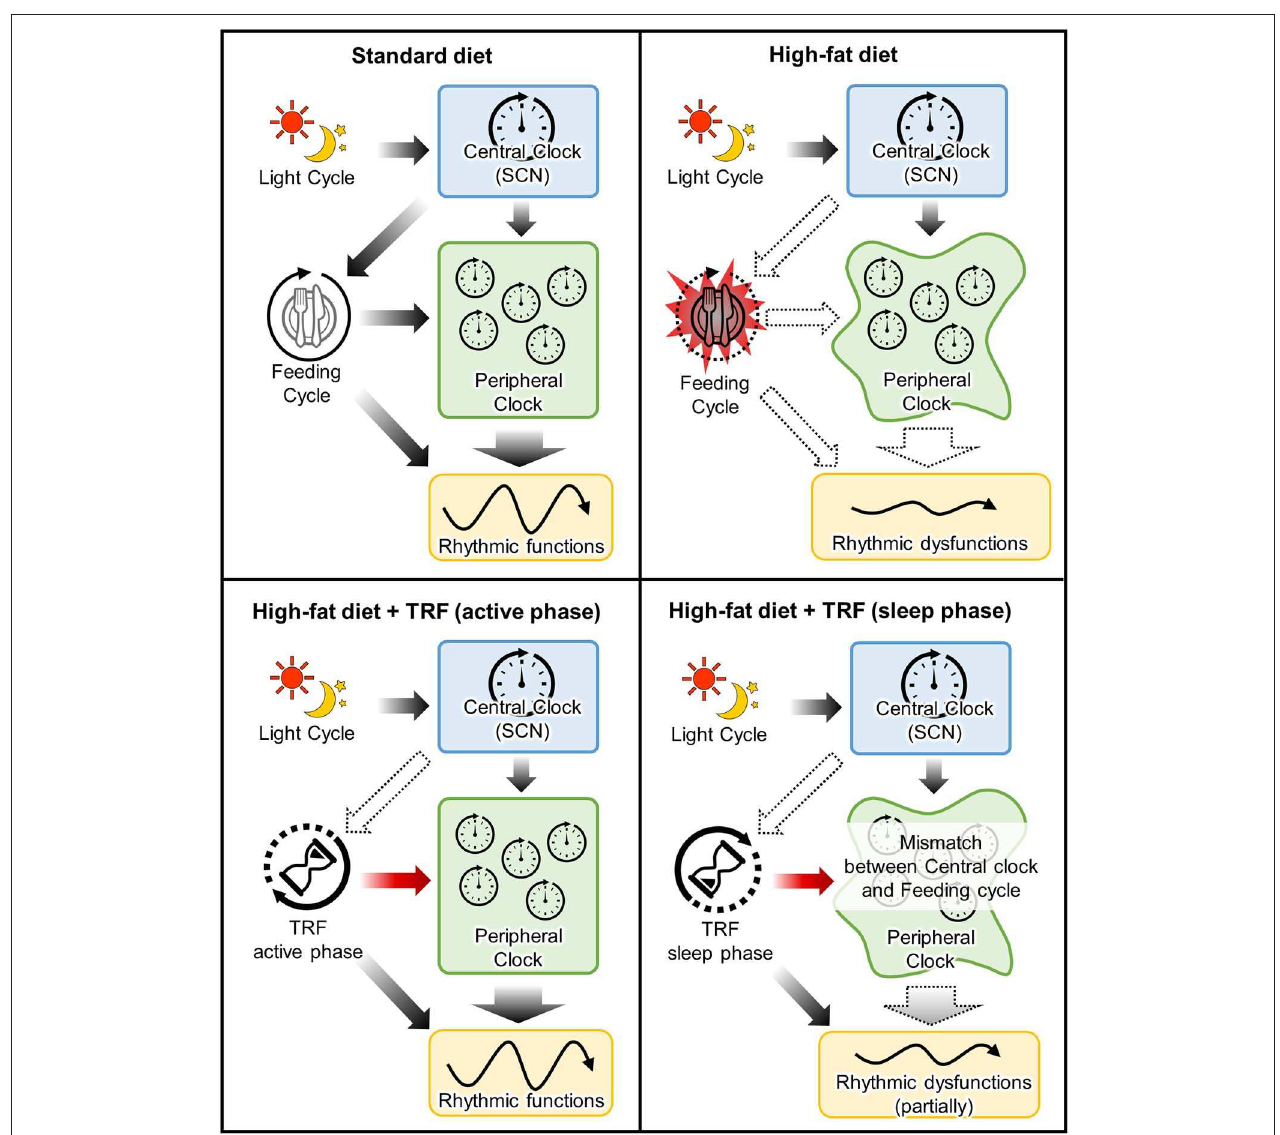
FIGURE 2 | Mechanistic insight into the effects of time-restricted-feeding during active or sleep phase. Upper left panel: In standard-diet-fed mice, timing of the entrainment cues between feeding cycle and central clock is matched for peripheral clocks. Upper right panel: High-fat-diet not only induced metabolic dysfunction due to a high calorie but also arrhythmic feeding cycle. This dysregulation of feeding cycle attenuates the feeding-induced-entrainment of peripheral clocks. Lower left panel: TRF during active phase rescues the attenuation of peripheral clock functions due to perturbation of feeding cycle. Lower right panel: Although TRF during sleep phase also entrains peripheral clocks, timing of the entrainment cues between feeding cycle and central clock is mismatched. It is suggested that this mismatch partially attenuates the beneficial effects of TRF.